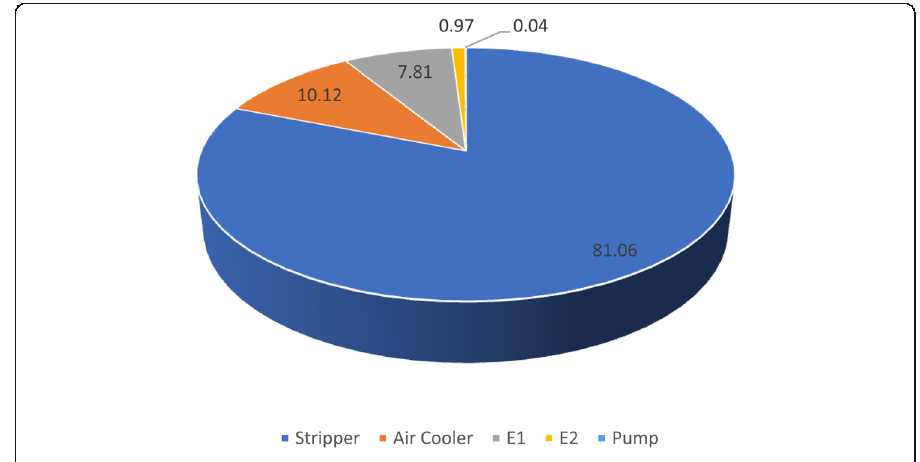
Fig. 8 Percentage share of